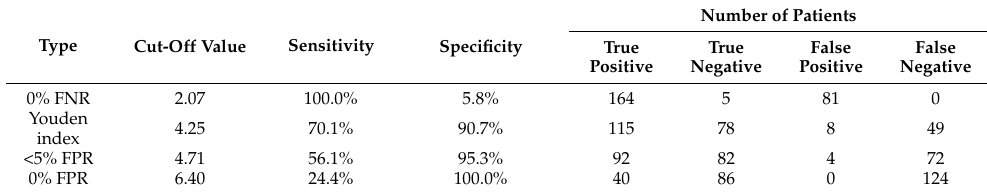
Table 3. Ion Shift Index cutoff values in predicting a poor neurological outcome at 6